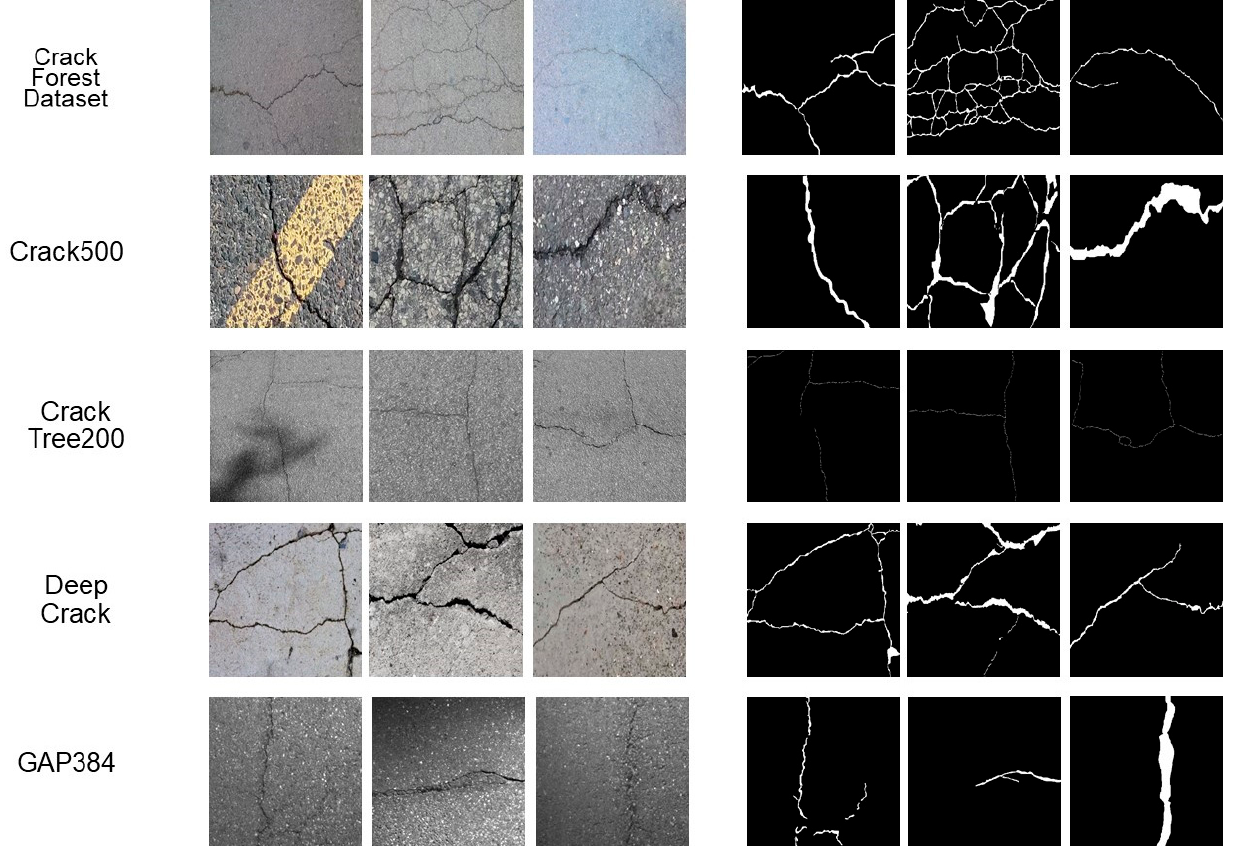
Figure 1. Crack segmentation datasets used in this study.